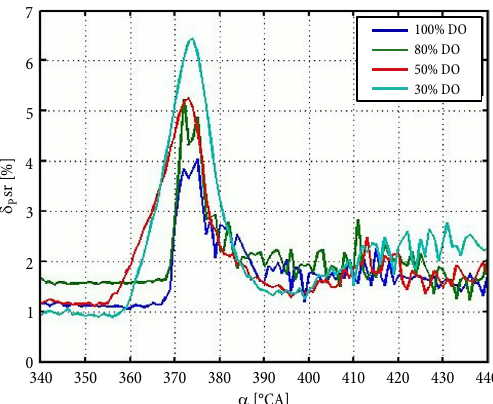
Fig. 6. Average recorded pressure versus CA for dual-fuel operation; n = 3400 rpm; T = 100 Nm (at different proportions of diesel oil)